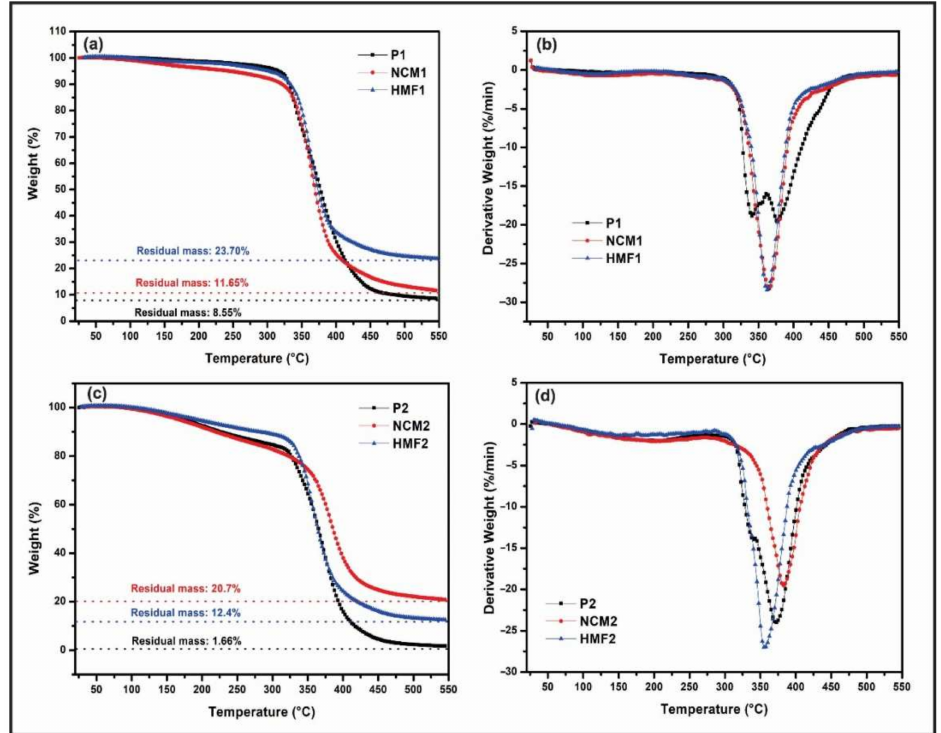
Figure 10. TGA and DTG analysis of the obtained materials. ( a , b ) Comparison of TGA and DTG analyses for P1, NCM1, and HMF1, respectively. ( c , d ) Comparison of TGA and DTG analyses for P2, NCM2, and HMF2, respectively.